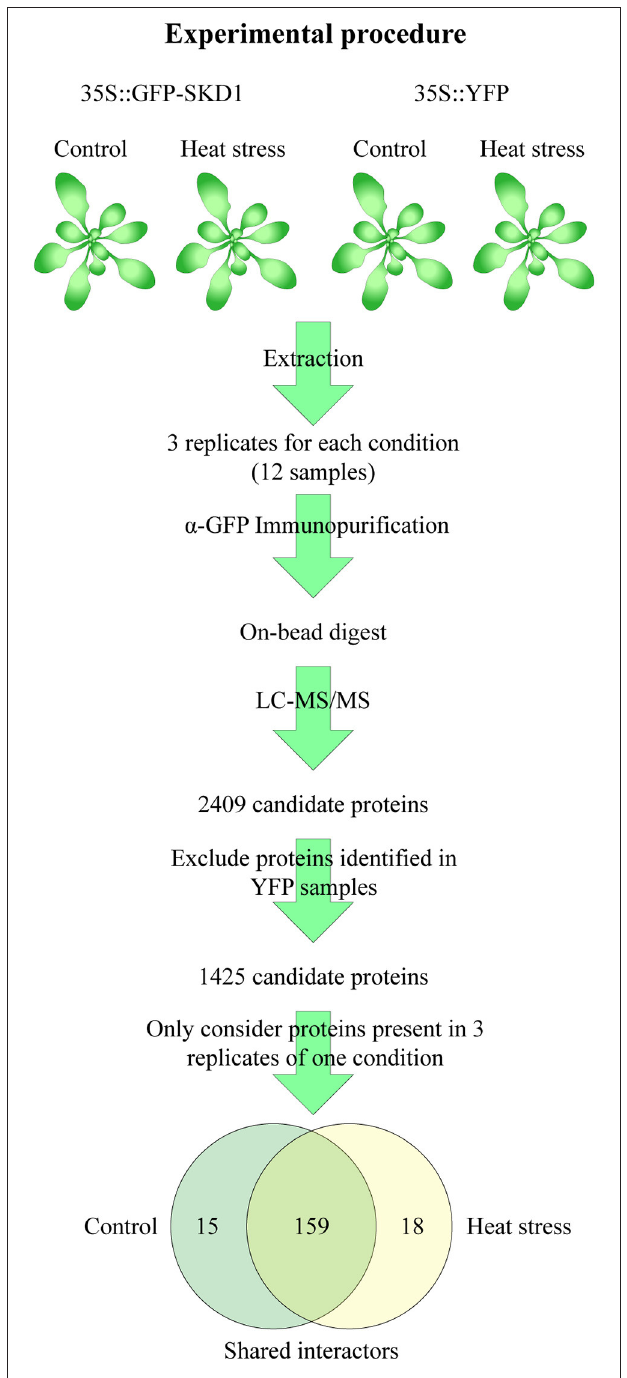
FIGURE 5 | Strategy of the SKD1 interactome identification. Proteins were extracted from rosette leaves of untreated or heat-treated transgenic 35S::GFP-SKD1 and 35S::YFP plants. The extracted proteins of three replicates of each genotype and condition (total: 12 samples) were subjected to immunoprecipitation using α -GFP-coated magnetic beads. The bound and washed proteins were not eluted but digested on the beads (Lys-C, Trypsin) and subjected to LC-MS/MS analysis. In total, 2,409 proteins were identified. Proteins identified in the YFP replicates were removed from the candidate